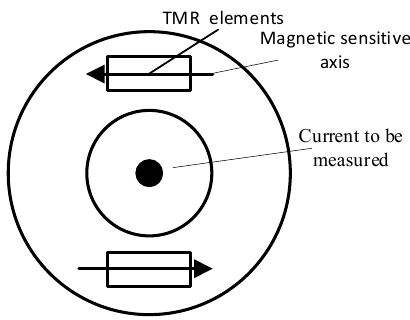
Figure 9. TMR sensor ring array layout diagram.